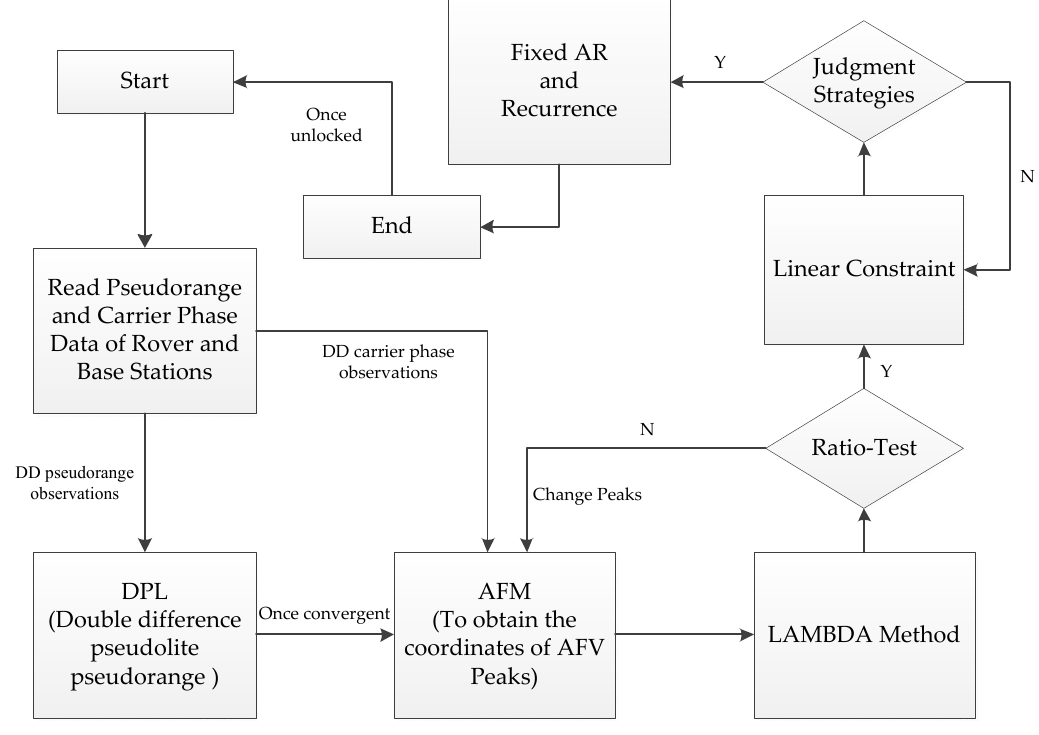
Figure 1. The procedure of the whole algorithm.